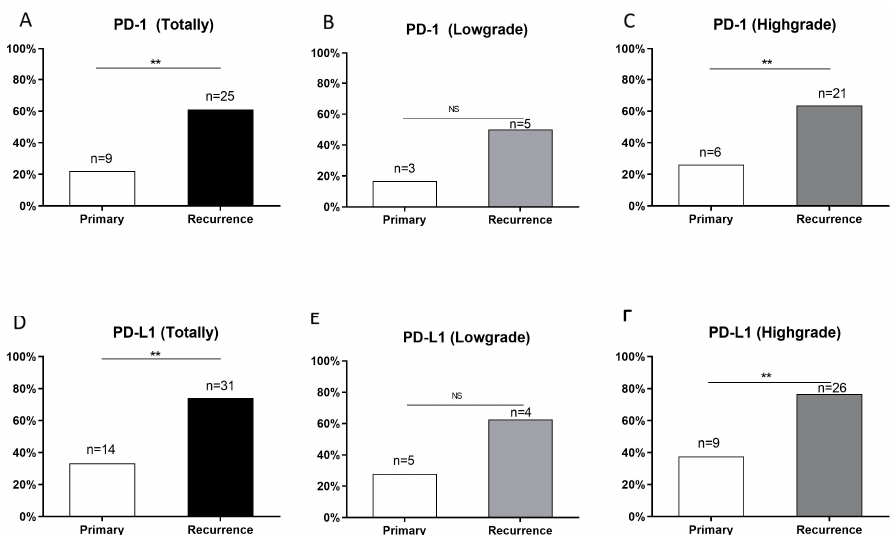
Figure 2. Expression of PD-1 and PD-L1 in primary and recurrent gliomas. ( A – C ) PD-1 expression in primary and recurrent gliomas in the cohort of totality, low-grade and high-grade gliomas. ( D – F ) PD-L1 expression in primary and recurrent gliomas in the cohort of totality, low-grade and high-grade gliomas. NS: no significance. **: p < 0.01.